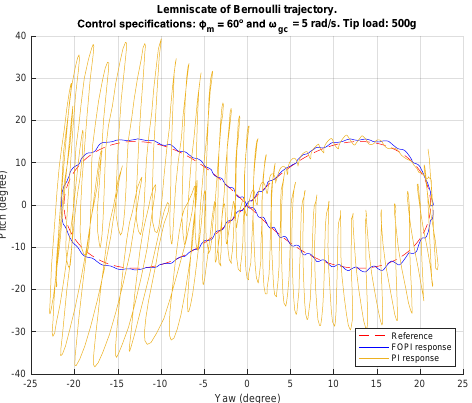
Figure 14. PI and FOPI system response to a lemniscate of Bernoulli input reference. Control specifications: φ m = 60 ◦ and ω gc = 5 rad/s. Tip load: 500